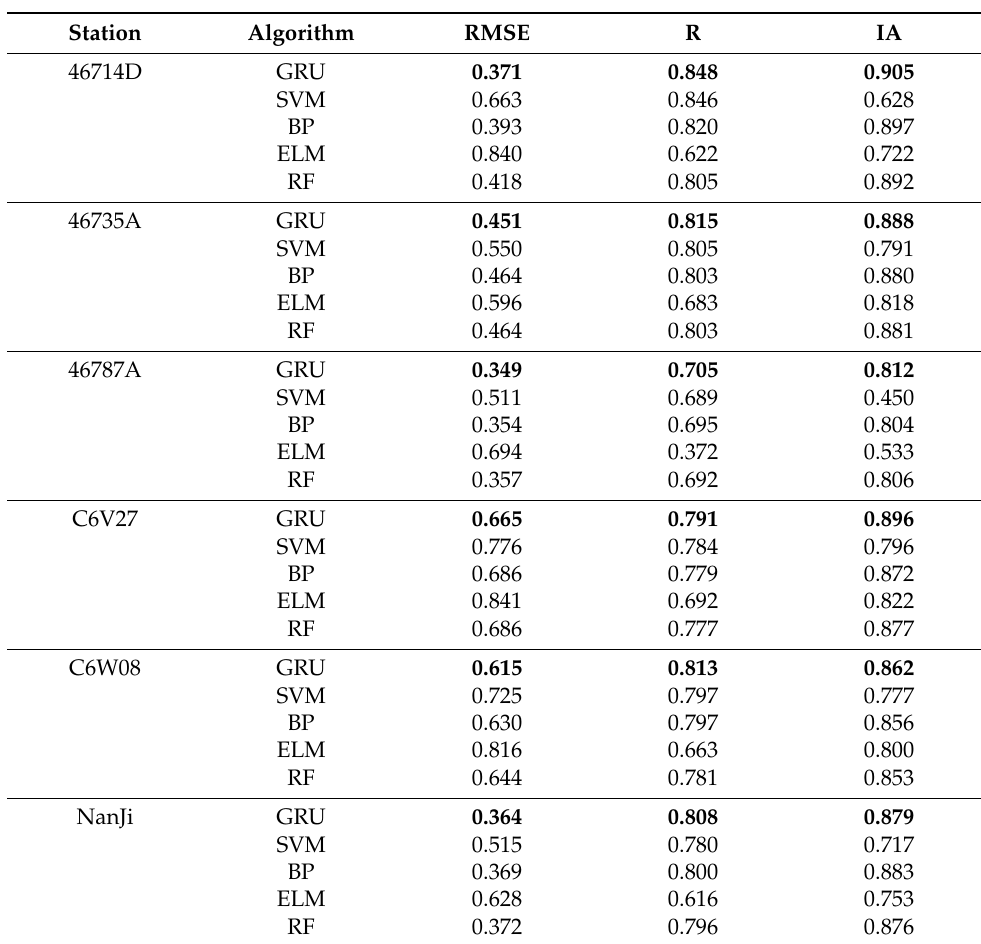
Table 5. Error indices of predicted SWH with lead times of 12